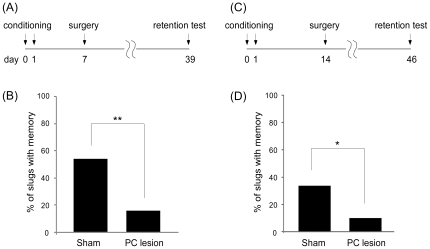
Odor-aversion memory was irreversibly lost after PC lesioning.(A) Time schedule of the experiment in which the bilateral PC were lesioned 7 days after conditioning. (B) A significantly higher percentage of sham-operated slugs (n = 37) show odor-aversion behavior than do PC-lesioned slugs (n = 38). (C) Time schedule of the experiment in which the PC was bilaterally lesioned 14 days after conditioning. (D) Sham-operated slugs (n = 30) show better memory retrieval than PC-lesioned slugs (n = 31). *P<0.05, **P<0.001 by χ2-test.